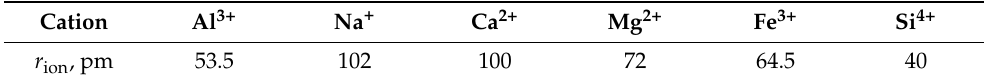
Table 8. Ionic radius of cations present in Al 2 O 3